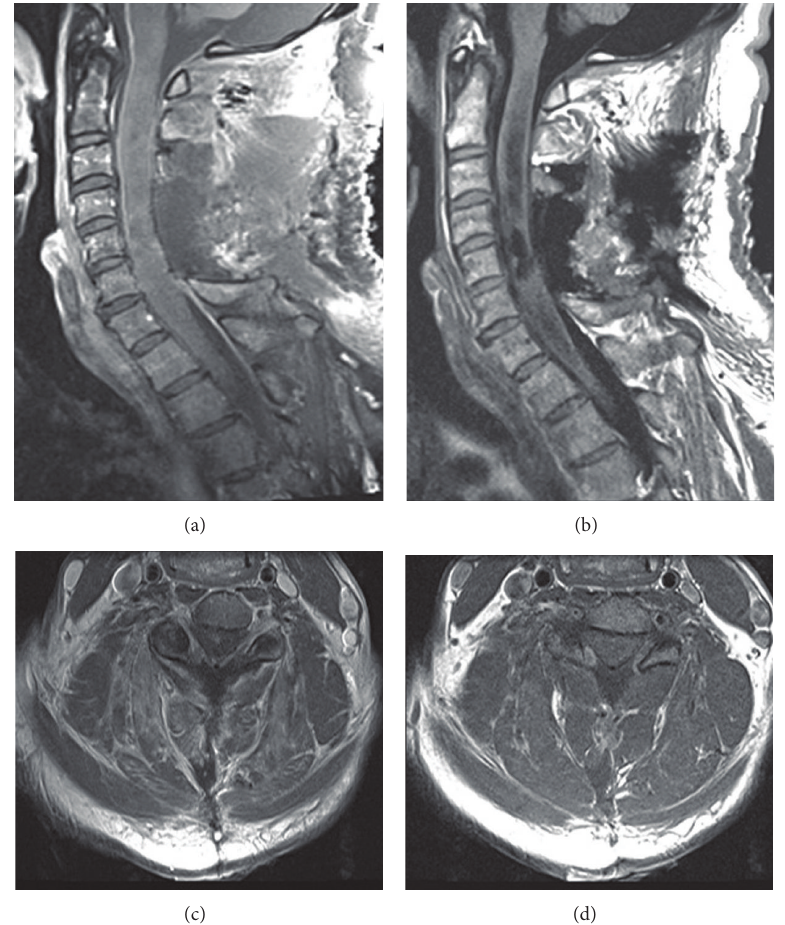
Figure 2: ((a), (c)) Sagittal and axial gadolinium enhanced T1-weighted images of the cervical spine after C3–C6 laminectomies and tumor resectiondemonstratingGTRwithnoresidualenhancement.((b),(d))SagittalandaxialT1-weightedinversionrecoveryimagesofthecervical spine after tumor resection demonstrating persistent cord syrinx and